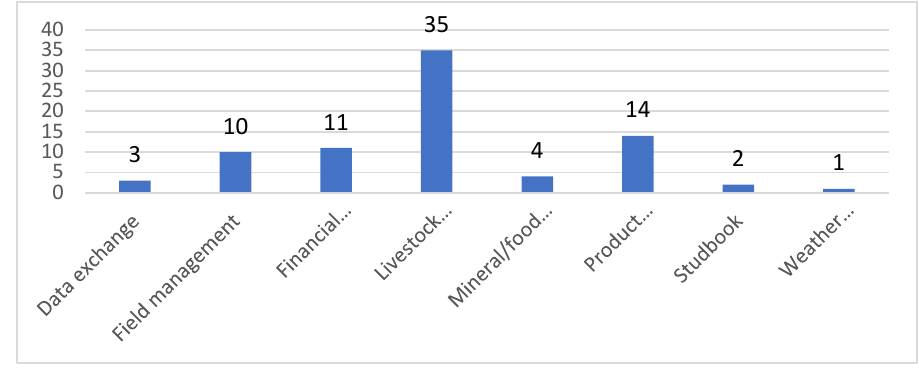
Figure 5. The number of times a field of focus of an FMIS is concerned by an FMIS.